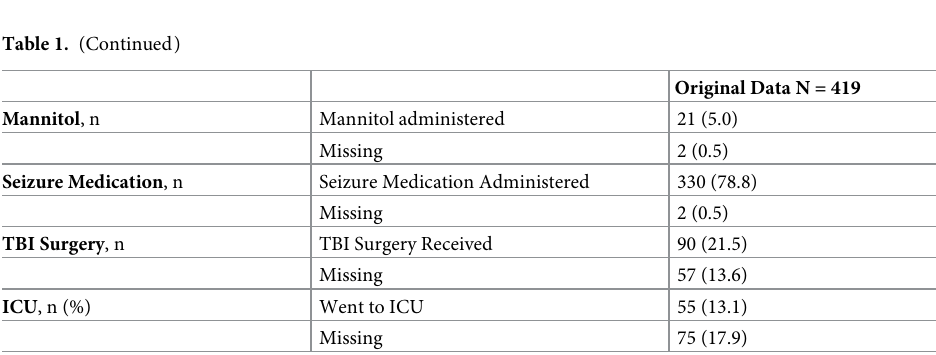
PLOS ONE | https://doi.org/10.1371/journal.pone.0273991 October 5,